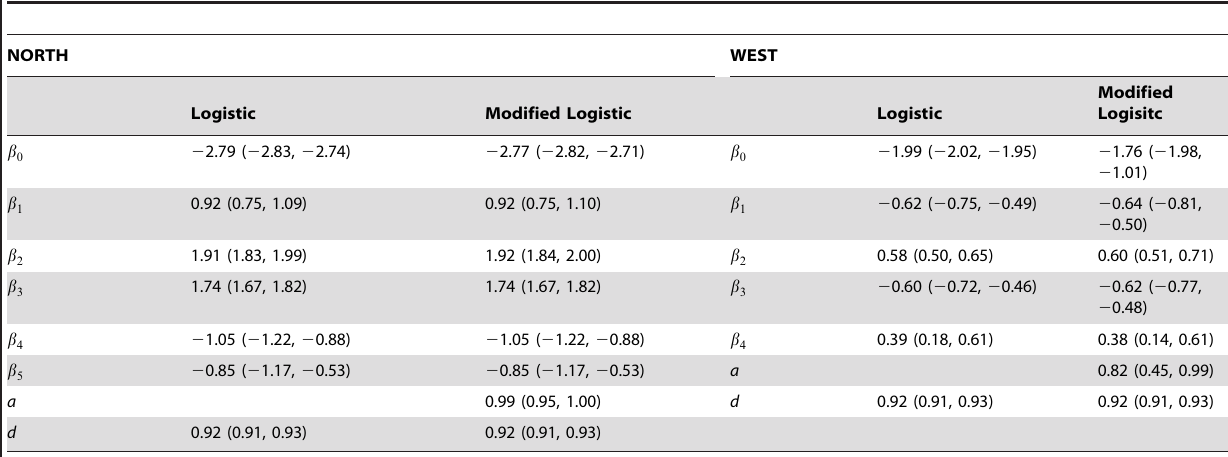
Table 1. We estimated model parameters of competing hypotheses of annual maxima of bison migrating beyond the northern and western boundaries of Yellowstone National Park during 1990–2009.